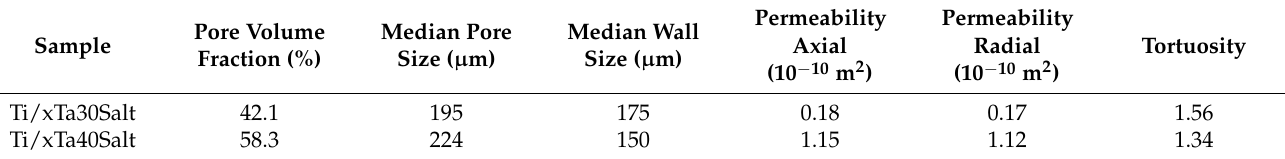
Table 2. Porosity and solid features of samples fabricated with different vol.% of salt